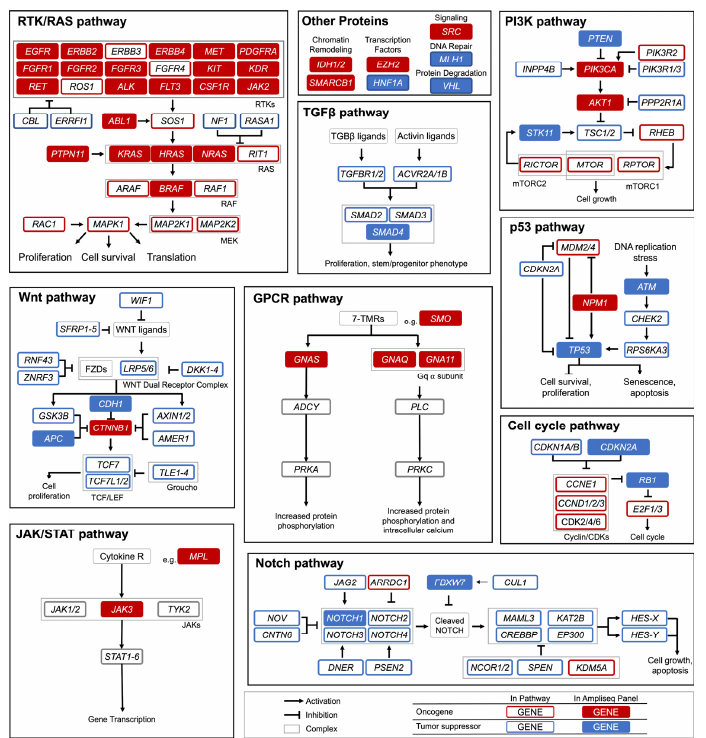
Figure 1. Signaling Pathways with Cancer Critical Genes. Hotspot panel genes in this study are shaded in red (oncogenes), and blue (tumor suppressor genes). RTK: Receptor Tyrosine Kinase; RAS: Rat Sarcoma; TGF β : Transforming Growth Factor Beta; PI3K: Phosphoinositide 3-kinase; GPCR: G- Protein Coupled Receptor; JAK: Janus Kinase; STAT: Signal Transducer and Activator of Transcription Proteins. Figure modified from Sanchez-Vega et al.